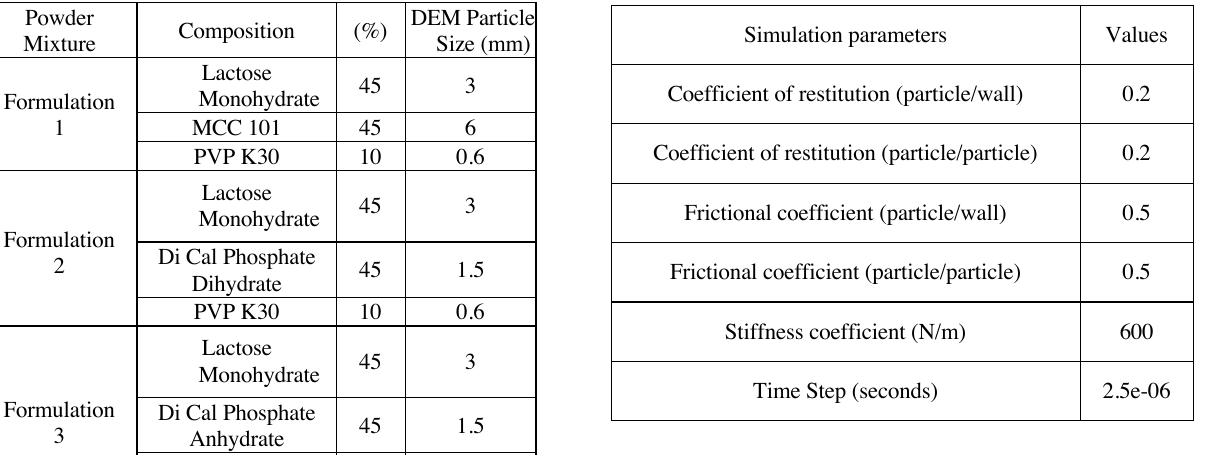
Table 2. Simulation parameters used in the DEM model Table 1. Composition of the blends as used in the study